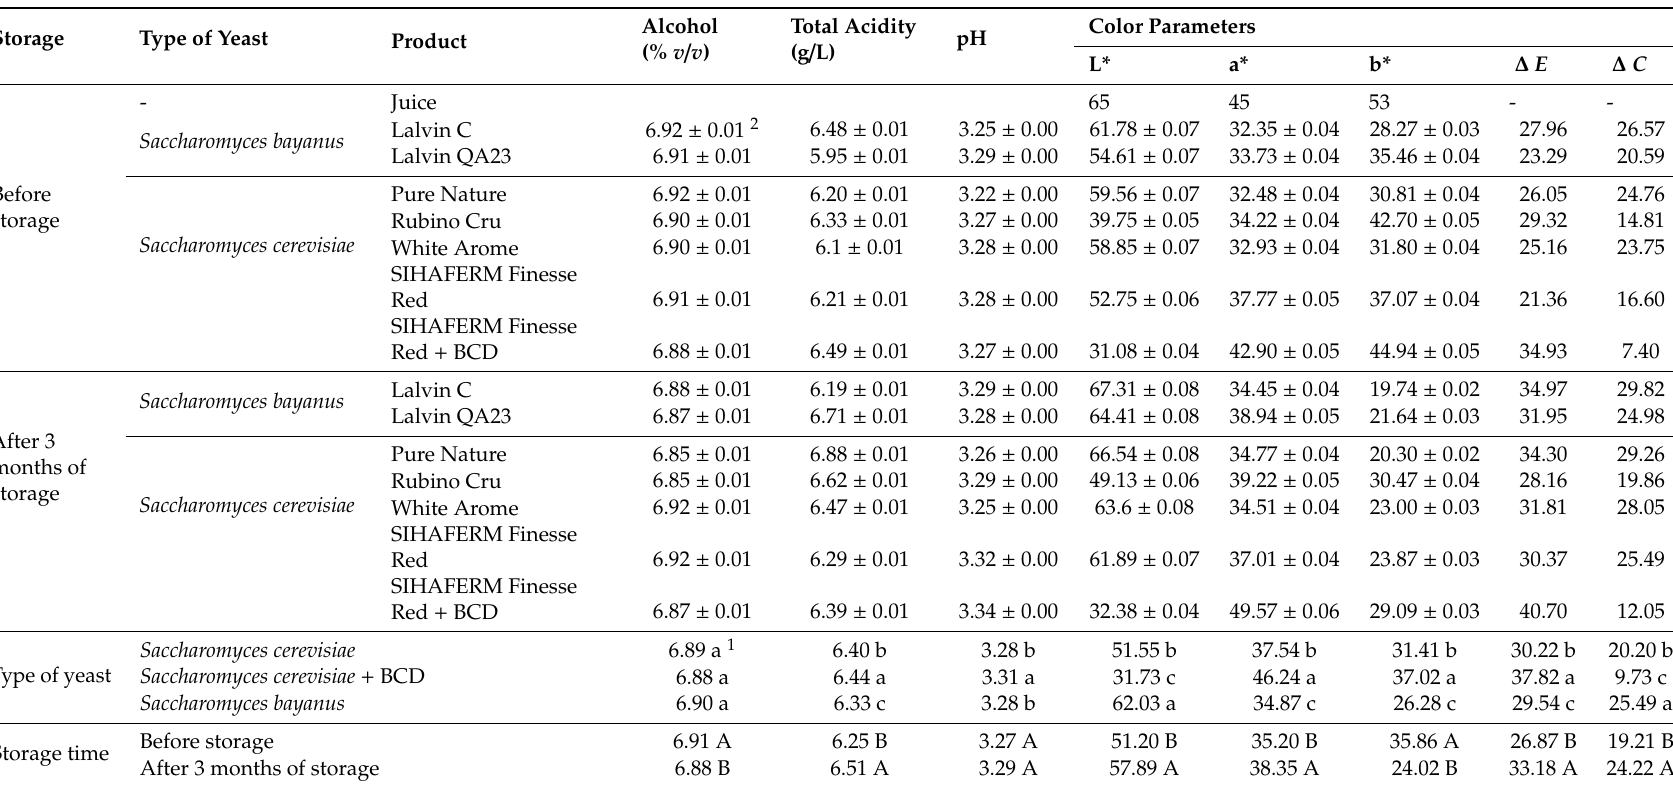
Table 1. The alcohol, total acidity, pH values, and color parameters in red apple ciders. L*—lightness; a*—redness; b*—yellowness; ∆ E—total color di ff erence; ∆ C—chroma di ff erence; BCD— β